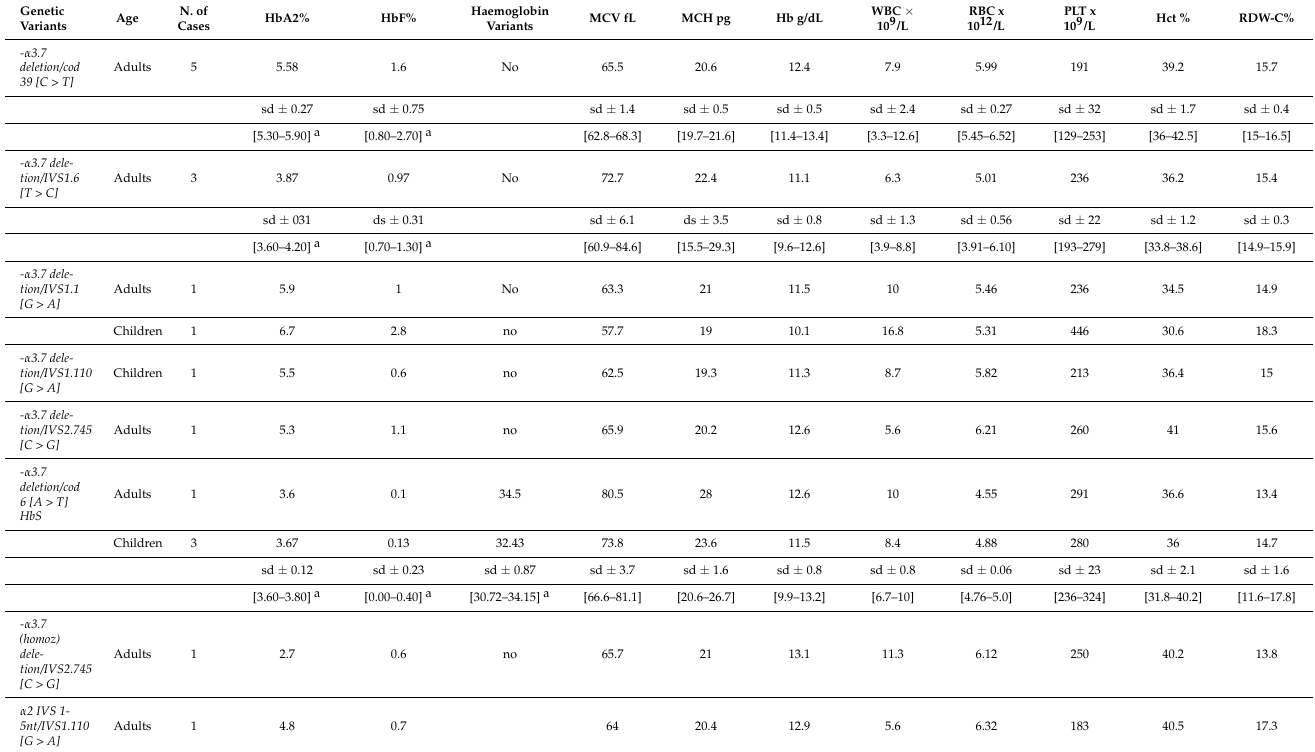
Table 6. Hematologic parameters (mean values and Standard Deviation (SD)) observed in subjects with mutation of the α -globin and β -globin